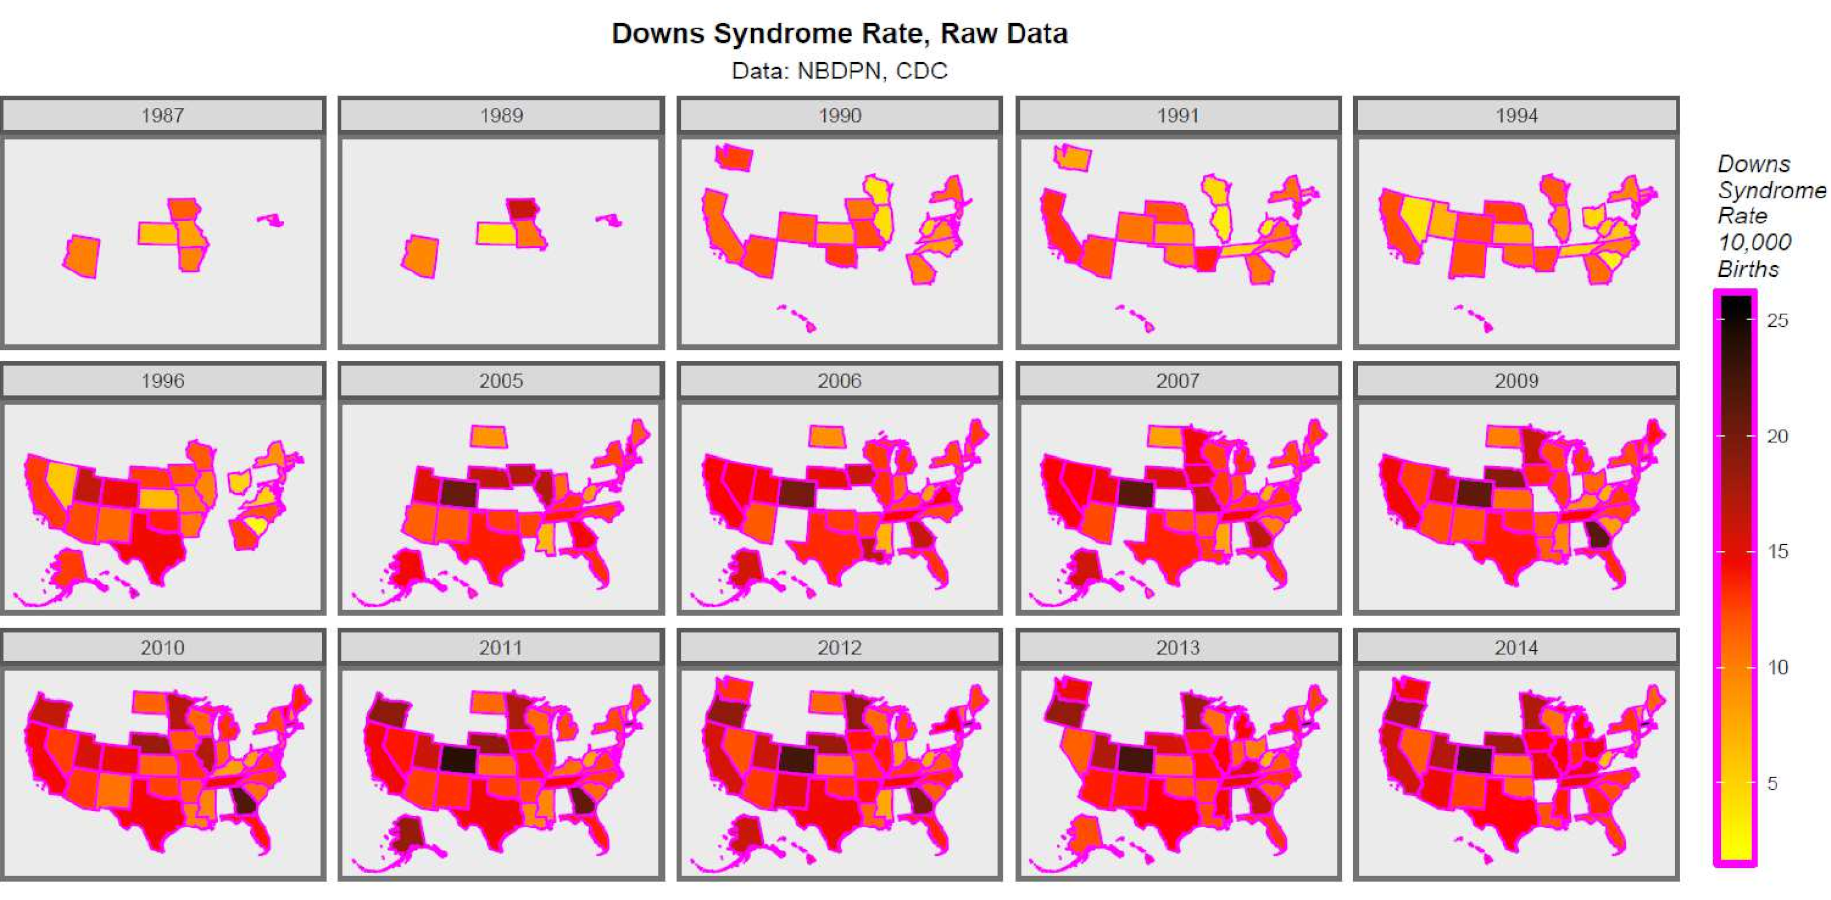
Figure 1. Map-graph of raw Down syndrome rates across USA